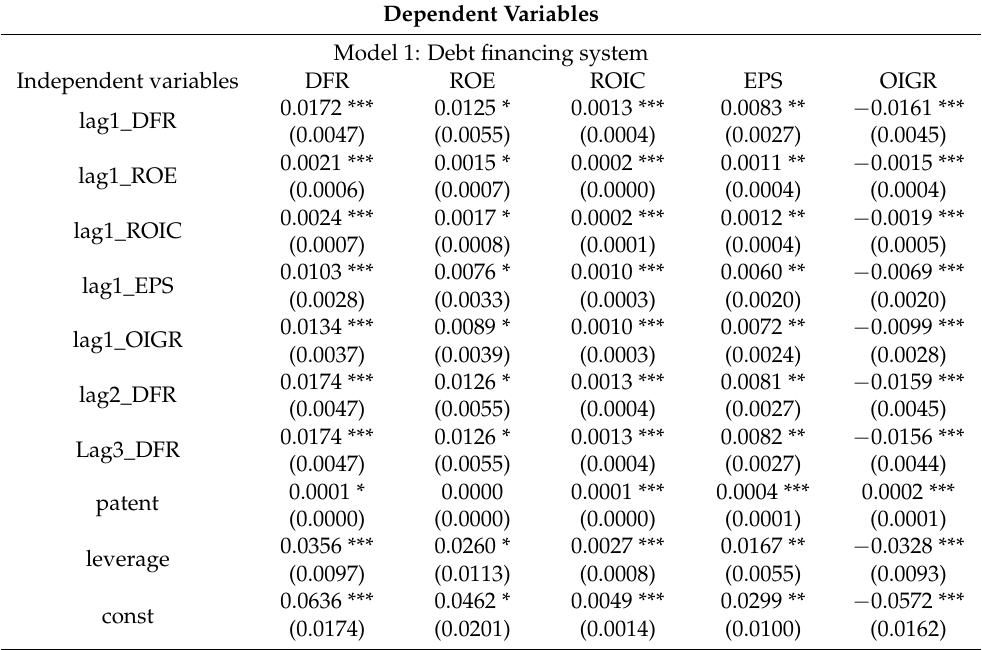
Table 5. The results of PVAR